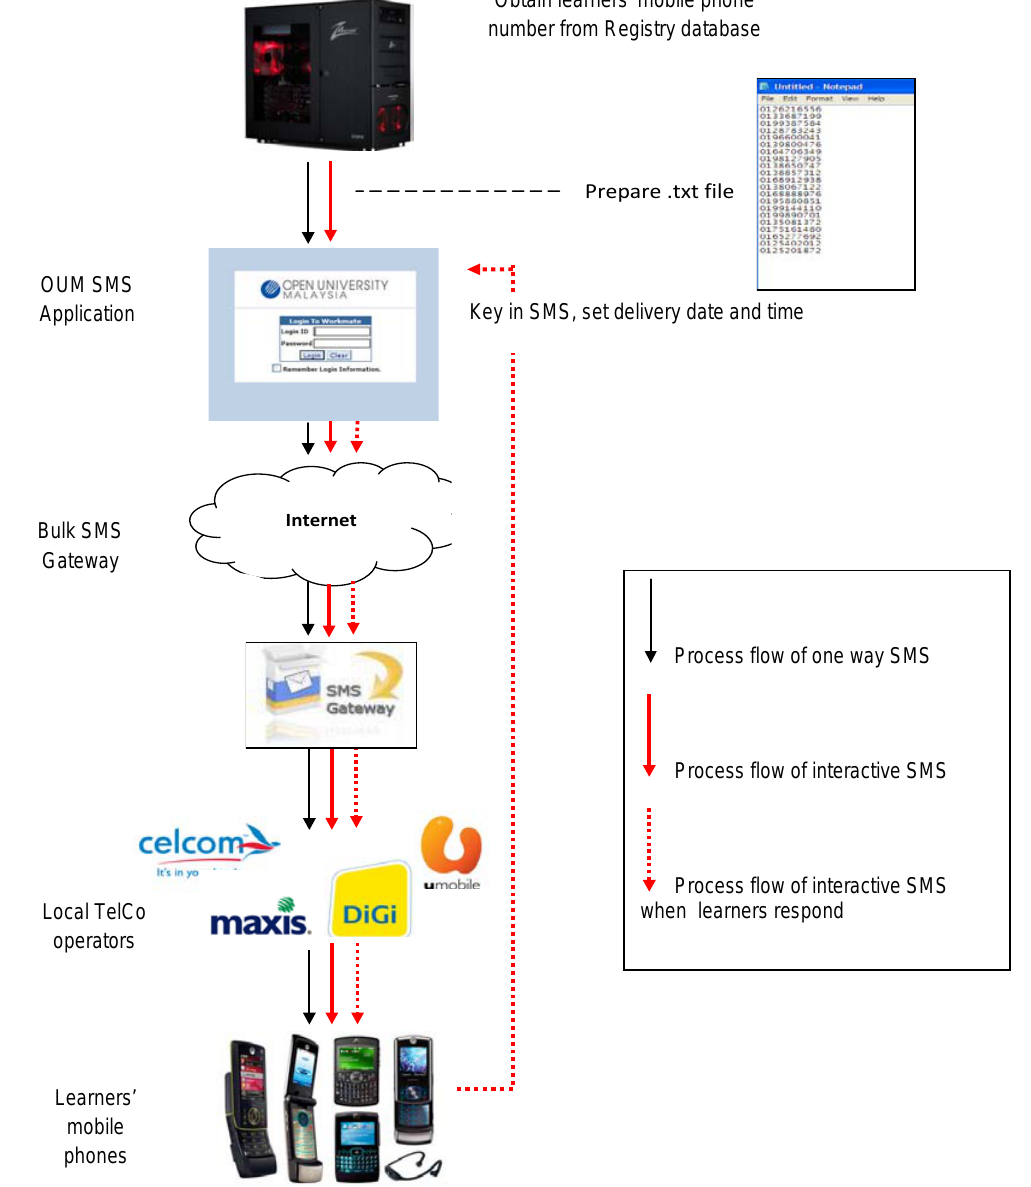
Figure 3. Process flow